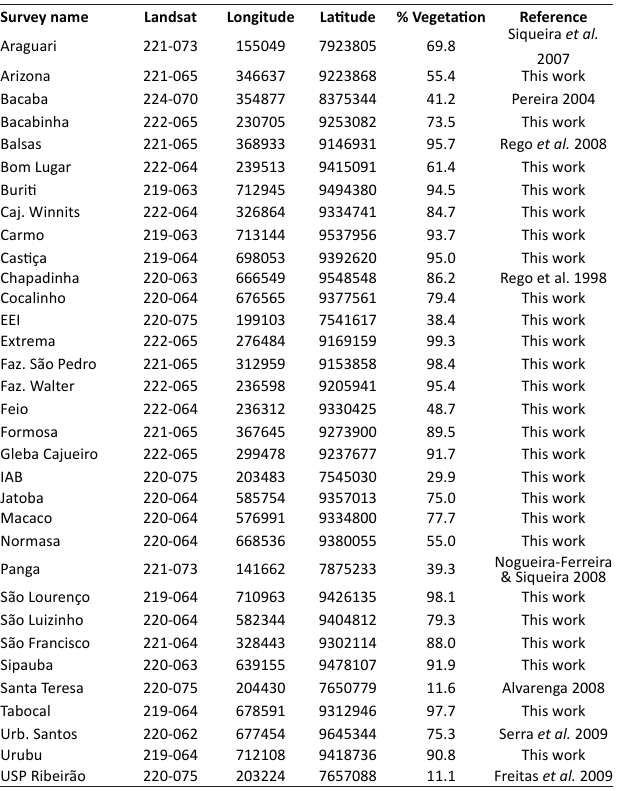
Table 1. Locations of the included nest surveys. Landsat: point-orbit of the Landsat satellite where the surveys were located. % Vegetation: amount of remnant Cerrado vegetation in each survey. Coordinates in UTM – SAD69. References in supplementary material available online.